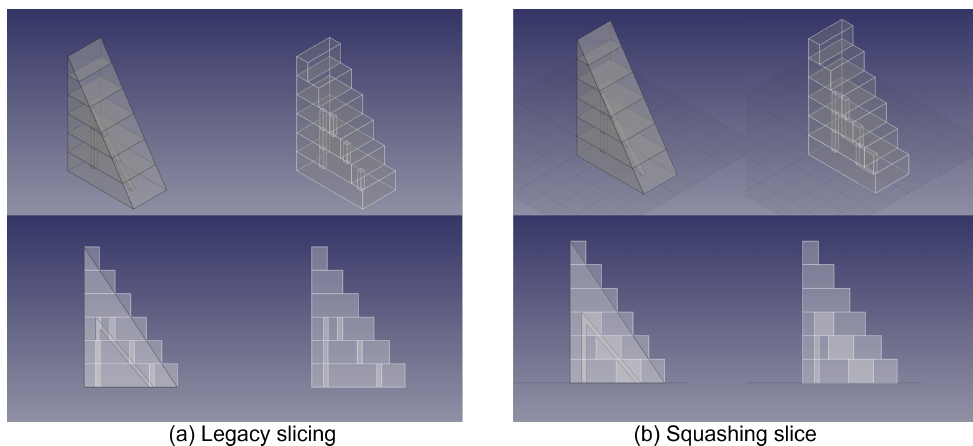
Figure 18. Inner micro structures sliced by legacy operation ( a ) and squashing operation ( b